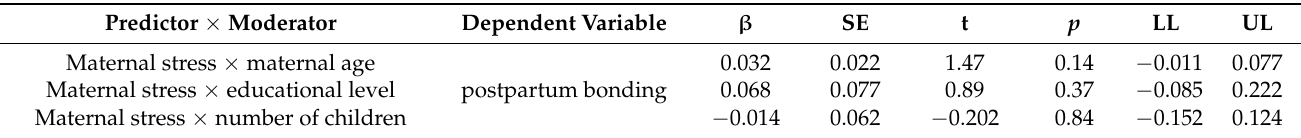
Table 7. Regression analysis of socio-demographical variables on the relationship between maternal stress and maternal postpartum